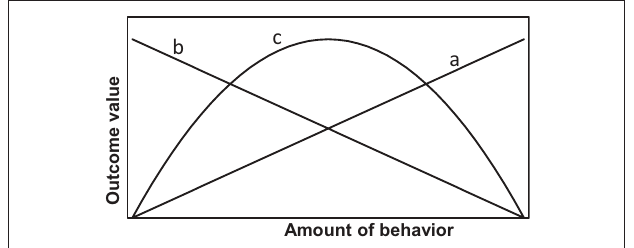
3 This requires that both behavior and goal features are assessed at least on an ordi- nal scale level; in the case of nominal scale level, as in most expected utility models, the analysis will be different but this cannot be done